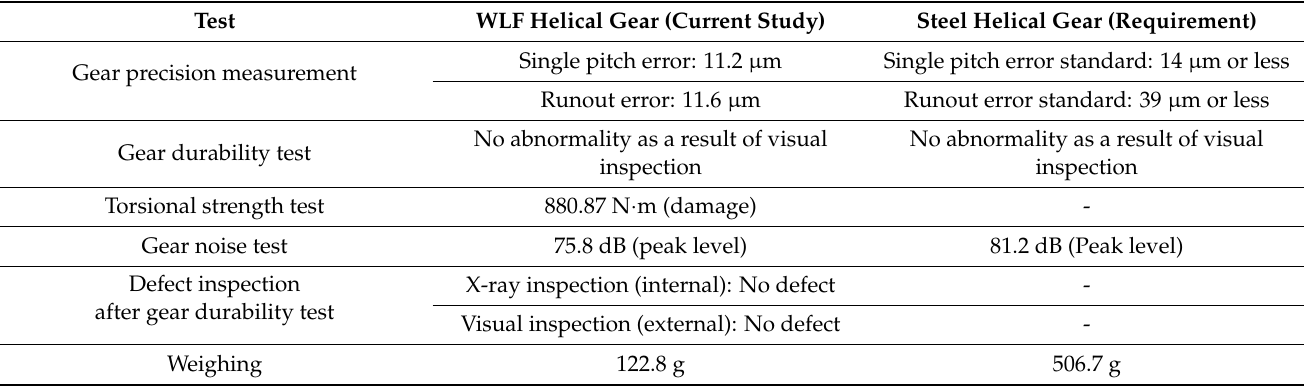
Table 7. Performance results of the WLF helical